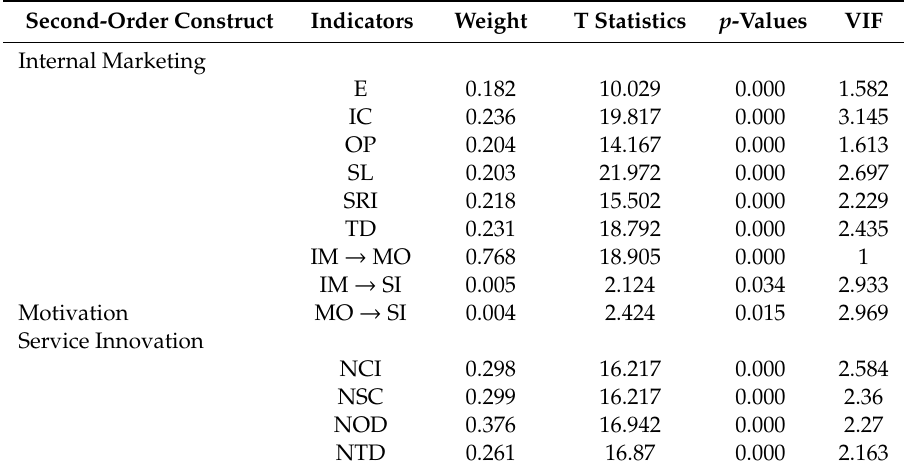
Table 5. Results of second-order indicators validity and first-order